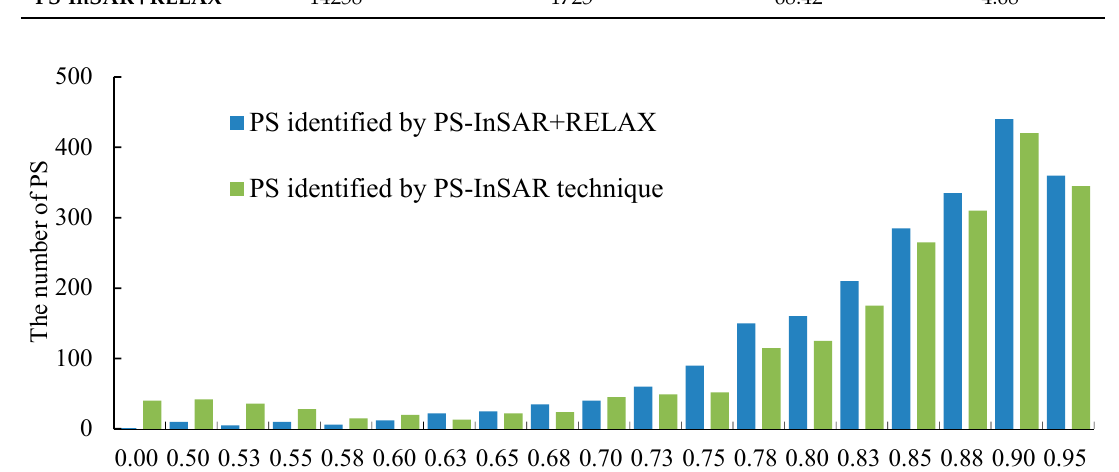
Table 3. Statistical overview of the PS identification using PS-InSAR+RELAX and PS-InSAR techniques.